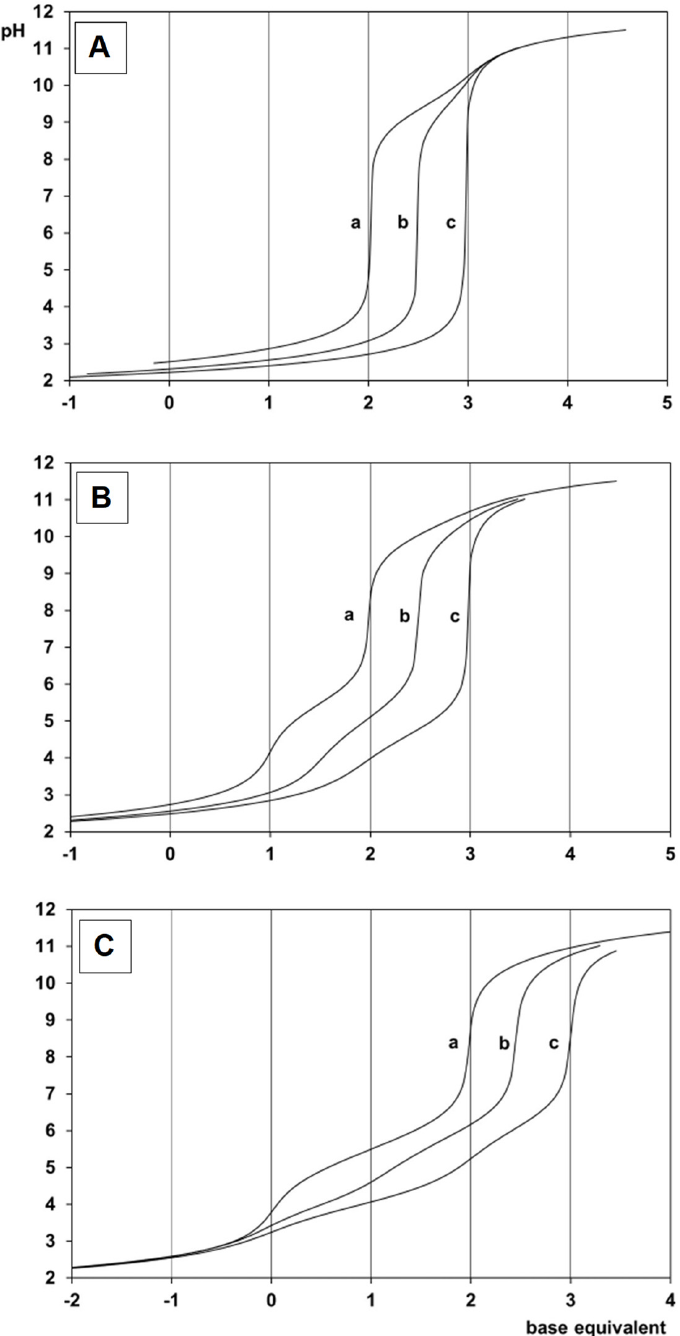
Figure 1. pH-potentiometric titration curves with Ida 2 − ( A ), IdaP 3 − ( B ), and Ida2P 4 − ( C ) for the H + –ligand system (a) and [( η 5 -Cp*)Rh] 2+ –ligand systems at 1:2 (b) and 1:1 (c) metal ion to ligand ratios. Negative base equivalent refers to an excess of acid in the sample. T = 25.0 °C, I = 0.20 M KCl.